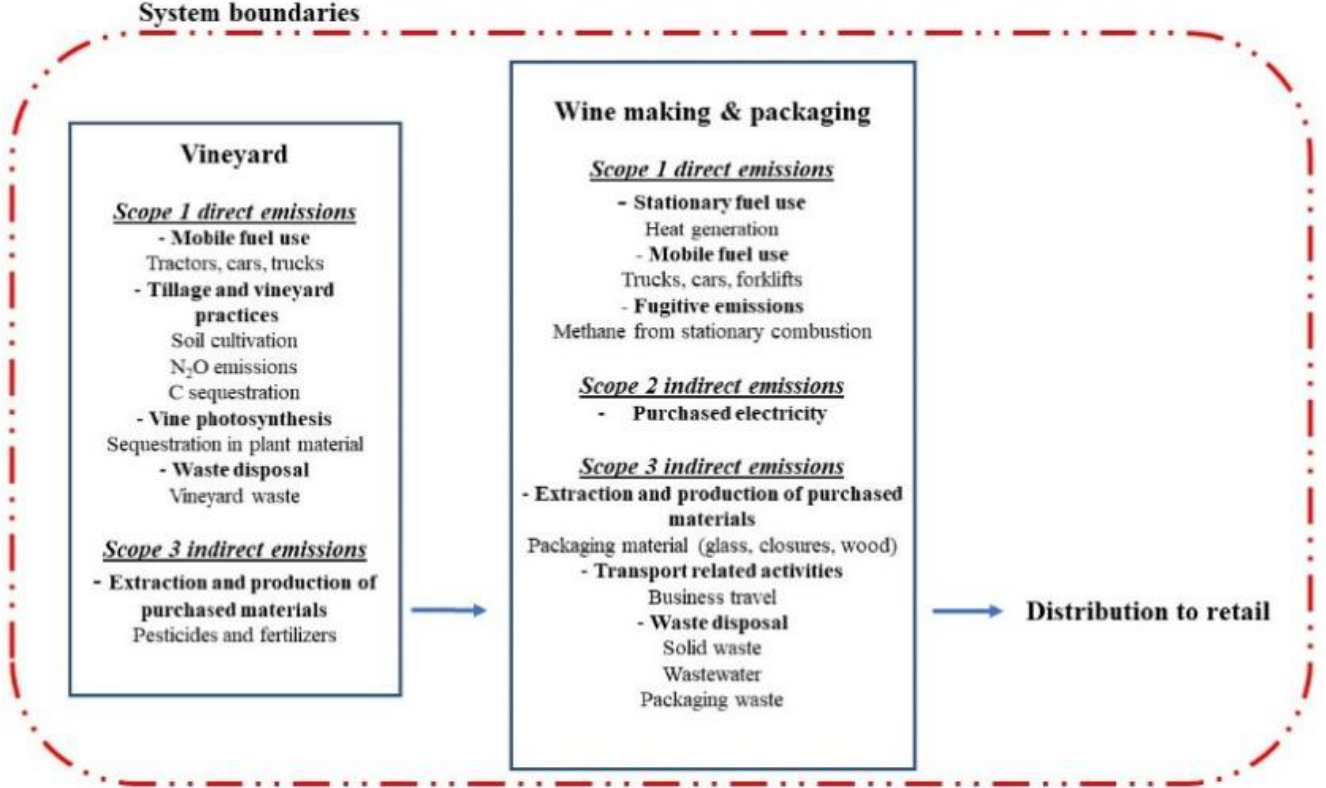
Figure 1. Operation process boundaries for the vineyard and winery and parameters accounted for greenhouse gas emissions (GHGE) calculation.